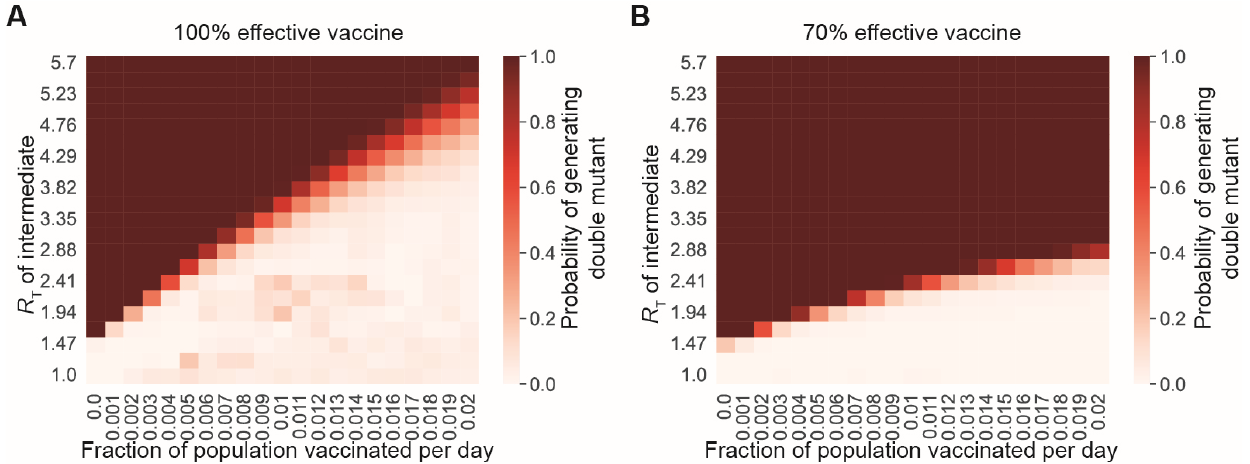
Figure 4. Vaccination alone will not prevent the generation of new variants, if transmission rates are high. ( A , B ) Probabilities of generating a double-mutant lineage before the extinction of the single mutant, for different values of the single-mutant transmissibility ( y -axis) and the fraction of the unvaccinated and the nonimmune population vaccinated per day ( x -axis). The vaccine is either completely effective in preventing infection from single-mutant variants ( A ) or 70% effective in preventing infection ( B ). For both panels, n = 1000 simulation was run, and the total population size was 300 million